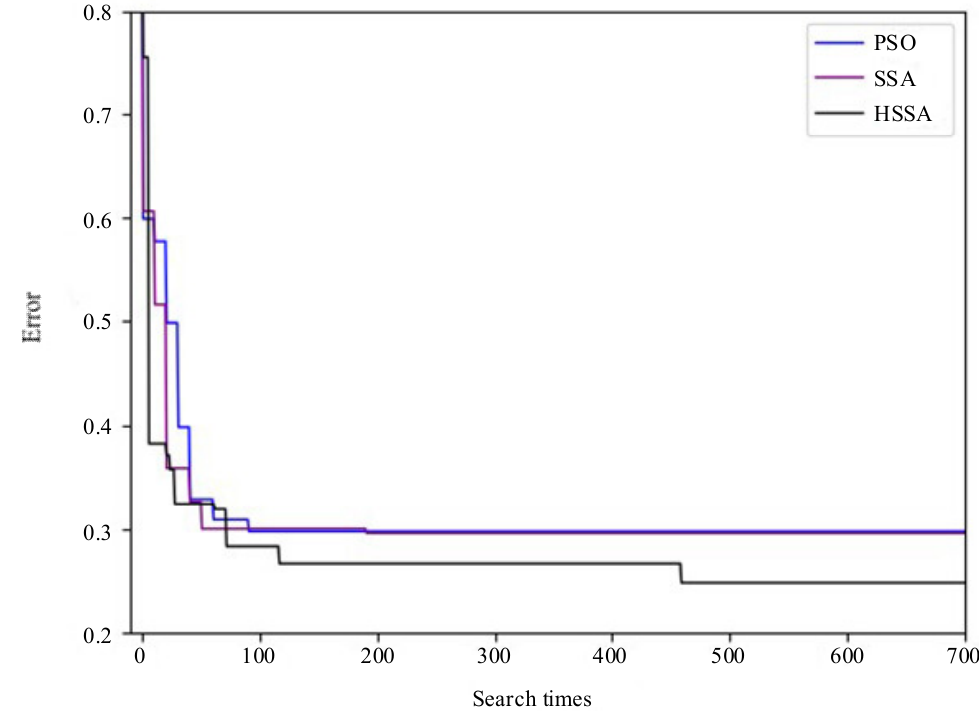
Figure 8. Results of the meaning verification experiment on MNIST.